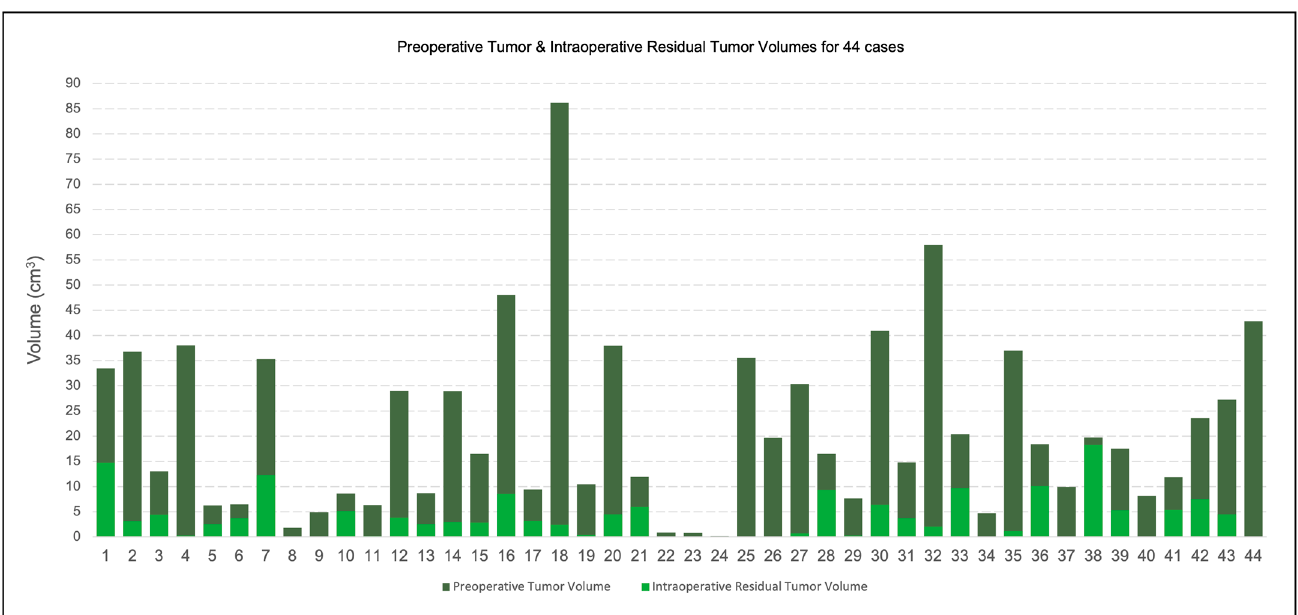
Figure 3. Distribution of preoperative tumor and intraoperative residual tumor volumes for all 44 cases. The light green bars represent the intraoperative residual tumor as a fraction of the underlaid dark green bars, which represent the preoperative tumor. Both bars share the same baseline. For additional details, see Appendix A, Table A1.